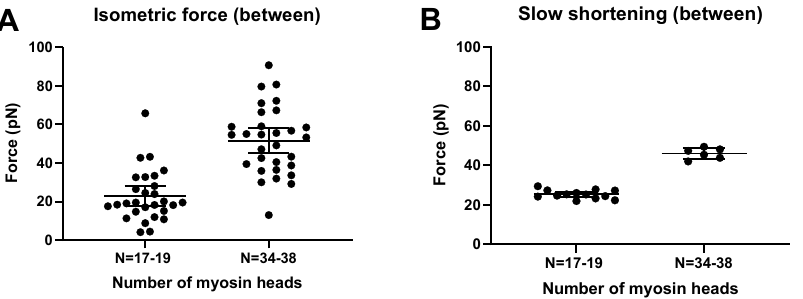
Figure 8. Simulated data for isometric force and for force during slow shortening ramps. ( A ) Isometric force from 28 simulation runs for N = 16–19 and 30 simulation runs for N = 33–39. Data given together with mean ± 95% CI. Each data point averaged over 15–55 data points during each simulation run. ( B ) Force during shortening ramps at 5% V 0 for same conditions as in ( A ). Note that there is an appreciably smaller difference between simulation runs in B than in the case of the isometric force in ( A